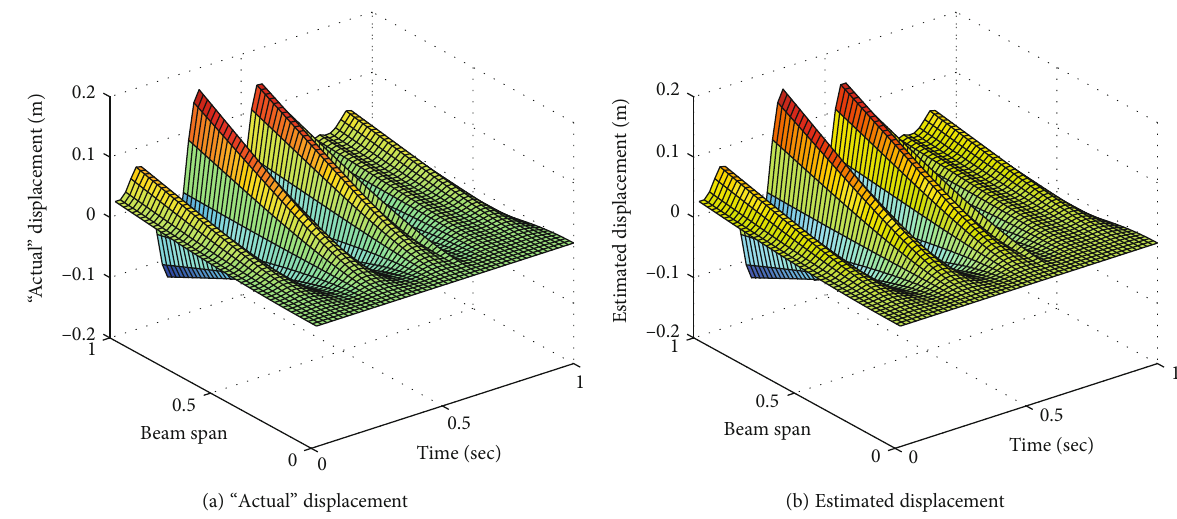
Figure 10: “ Actual ” and estimated displacement along the beam from 0 to 1 s.